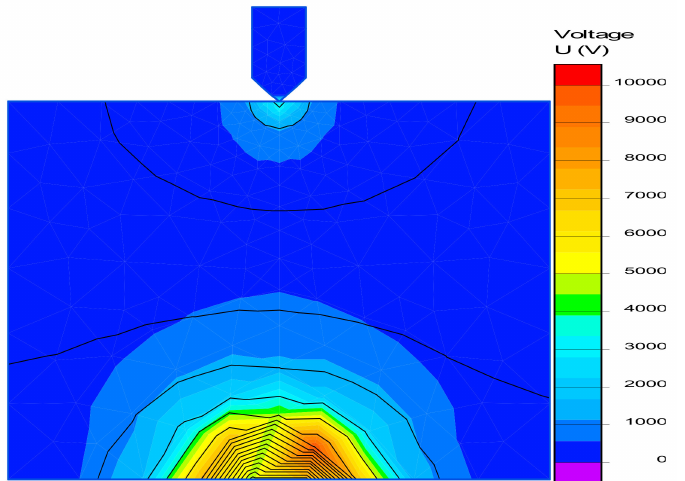
Figure 10. Surface plot of laterite bentonite.